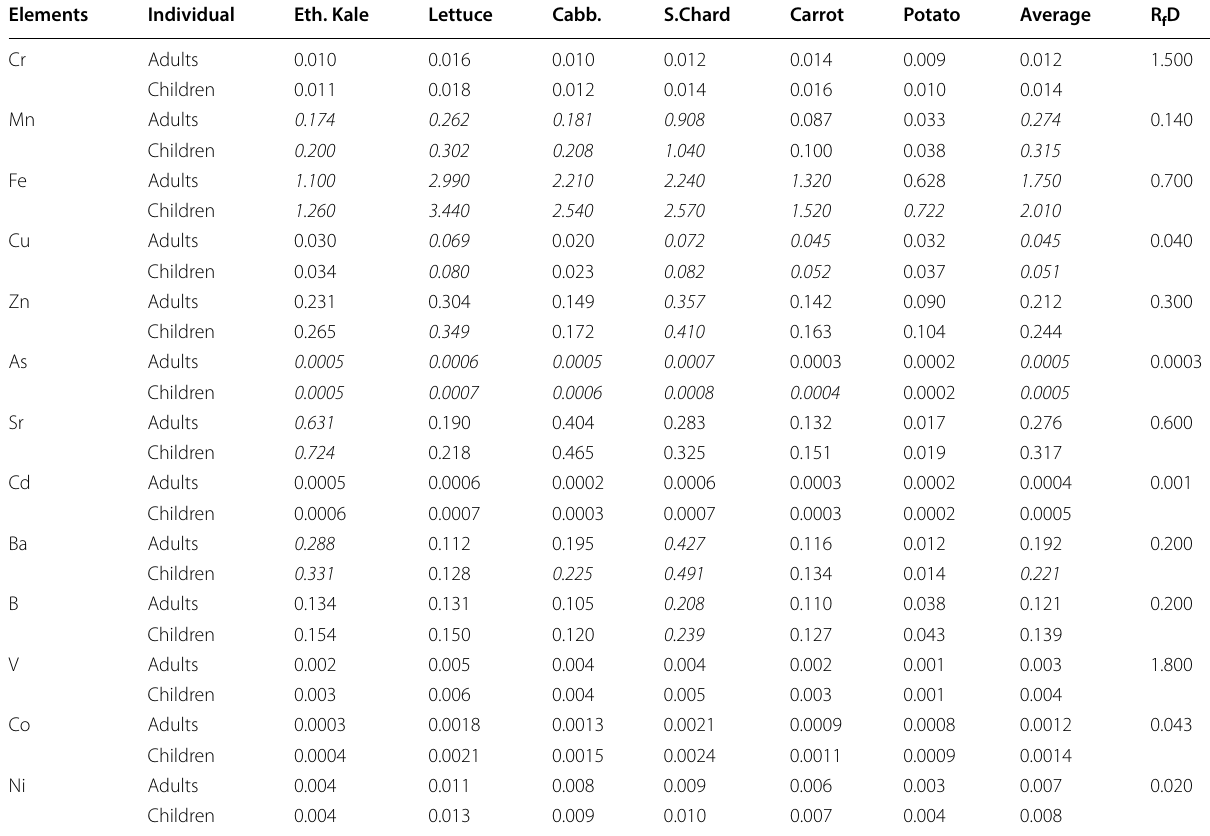
Table 5 Average daily intake of PTEs through consumption of vegetables